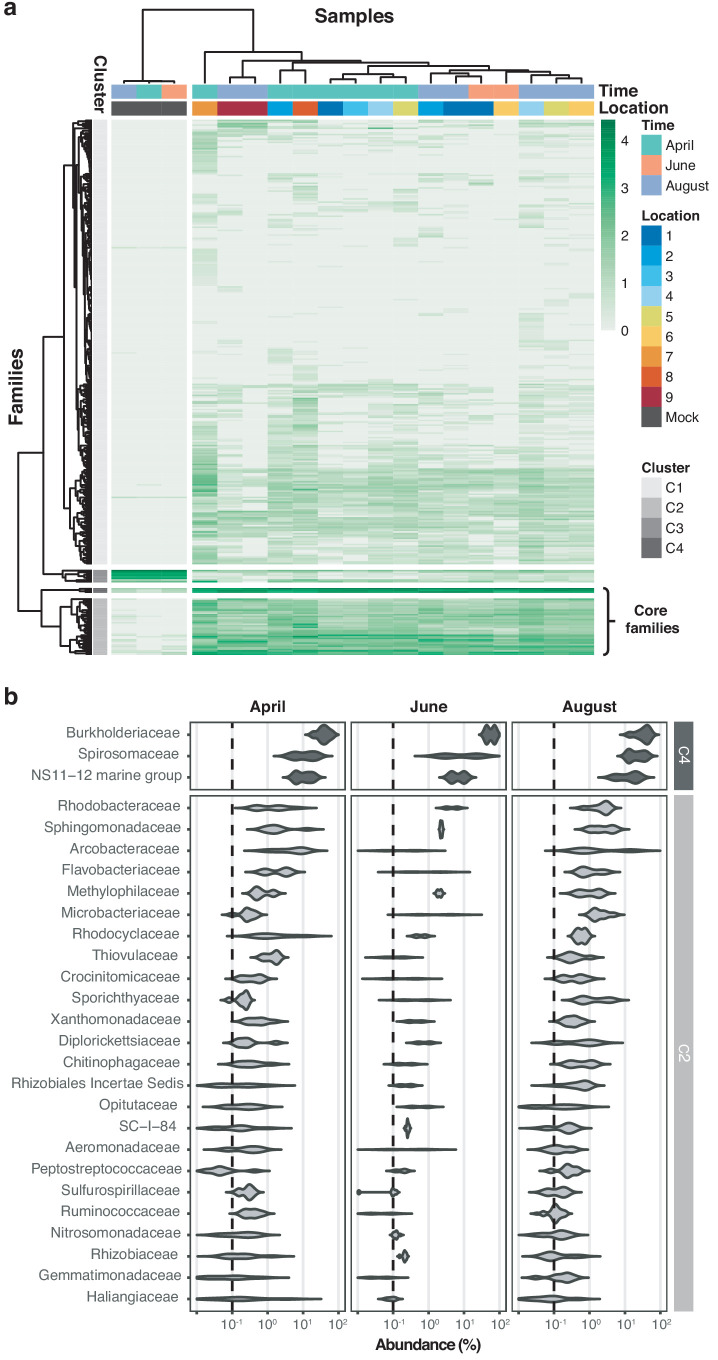
Core microbiome of the River Cam.(a) Hierarchical clustering of bacterial family abundances across freshwater samples after rarefaction, together with the mock community control. Four major clusters of bacterial families occur, with two of these (C2 and C4) corresponding to the core microbiome of ubiquitously abundant families, one (C3) corresponding to the main mock community families and one (C1) corresponding to the majority of rare accessory taxa. (b) Detailed river core microbiome. Violin plots summarise fractional representation of bacterial families from clusters C2 and C4 (log10 scale of relative abundance [%] across all samples, nApril = 7, nJune = 2, nAugust = 7), sorted by median total abundance. Vertical dashed lines depict 0.1% proportion.